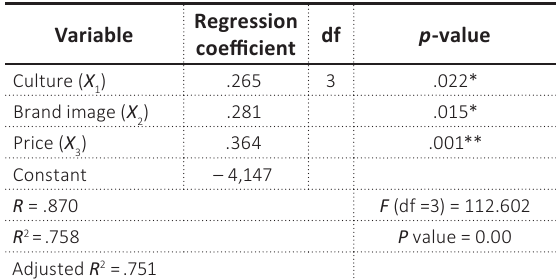
Table 4. Multiple linear regression